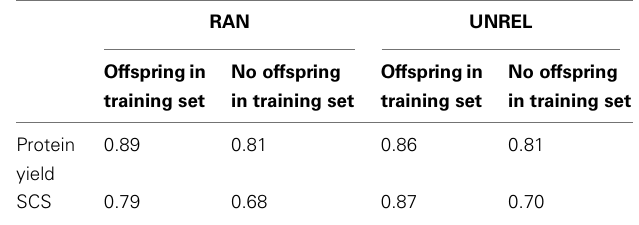
Table 5 |Accuracy measured as the correlation between direct genomic values and realized PTA in the testing set for protein yield and somatic cell score (SCS) in sires with and without offspring in the training set, as estimated from the random (RAN) and theA-matrix decomposition (UNREL)